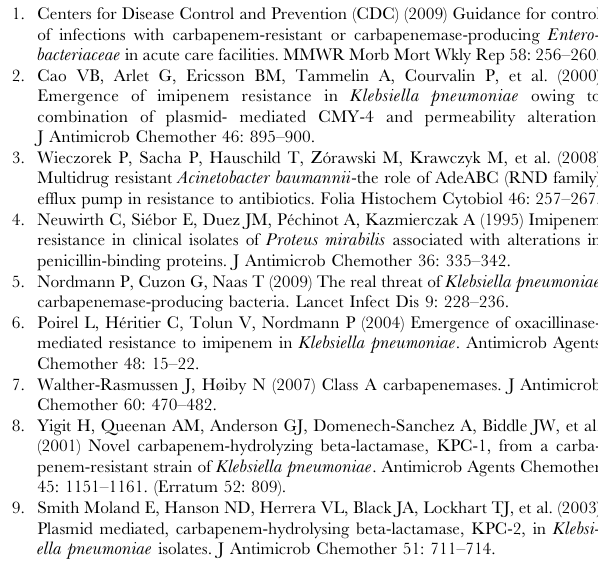
Table S1 The quantitative values of the initial rate versus substrate concentration (v 0 /[s]) for KPC-15 and KPC-2 enzymes.